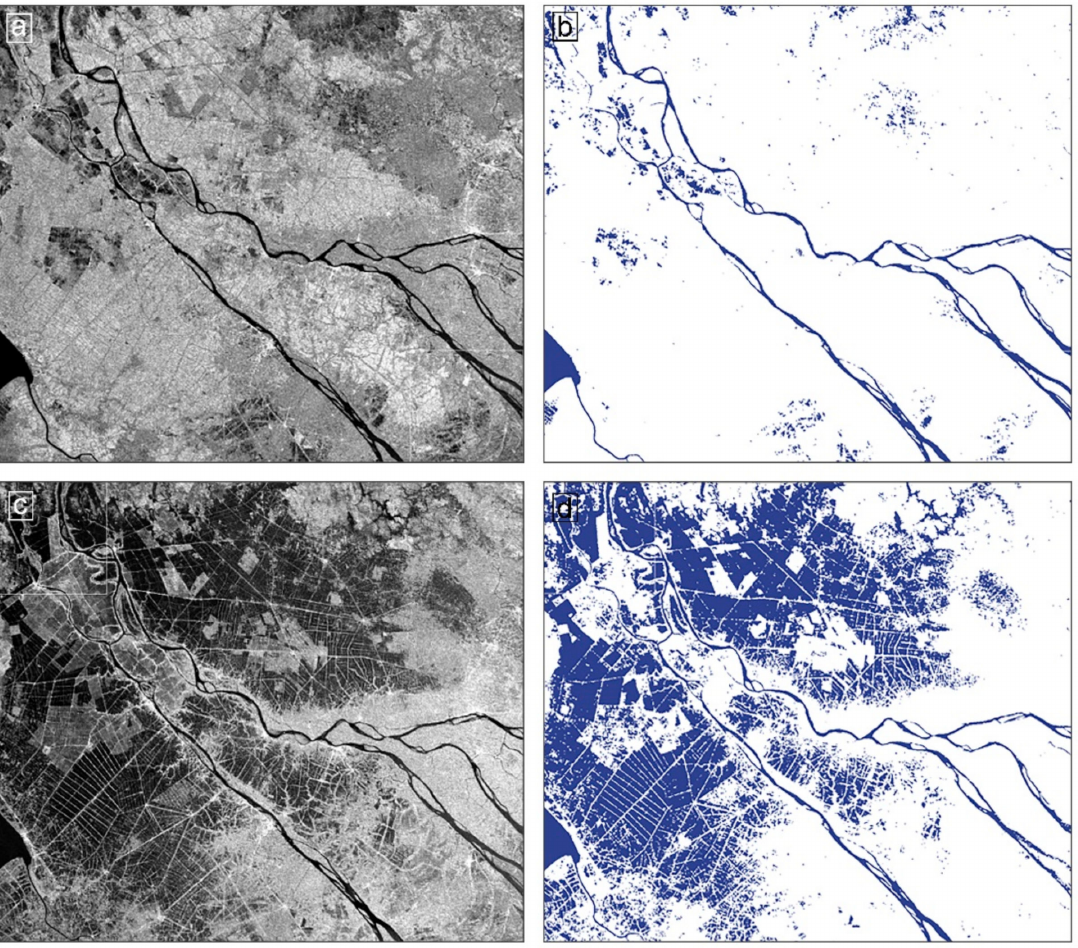
Figure 7. General schematic principle of water surface extraction from SAR data: water surfaces act as mirror reflectors for incident SAR waves, and thus backscatter values are low. Excerpt of a SAR image showing the Mekong Delta during the dry season ( a ) surface water areas mapped from the same image ( b ), SAR image for same excerpt ( c ) and mapped surface water ( d ) during the rainy